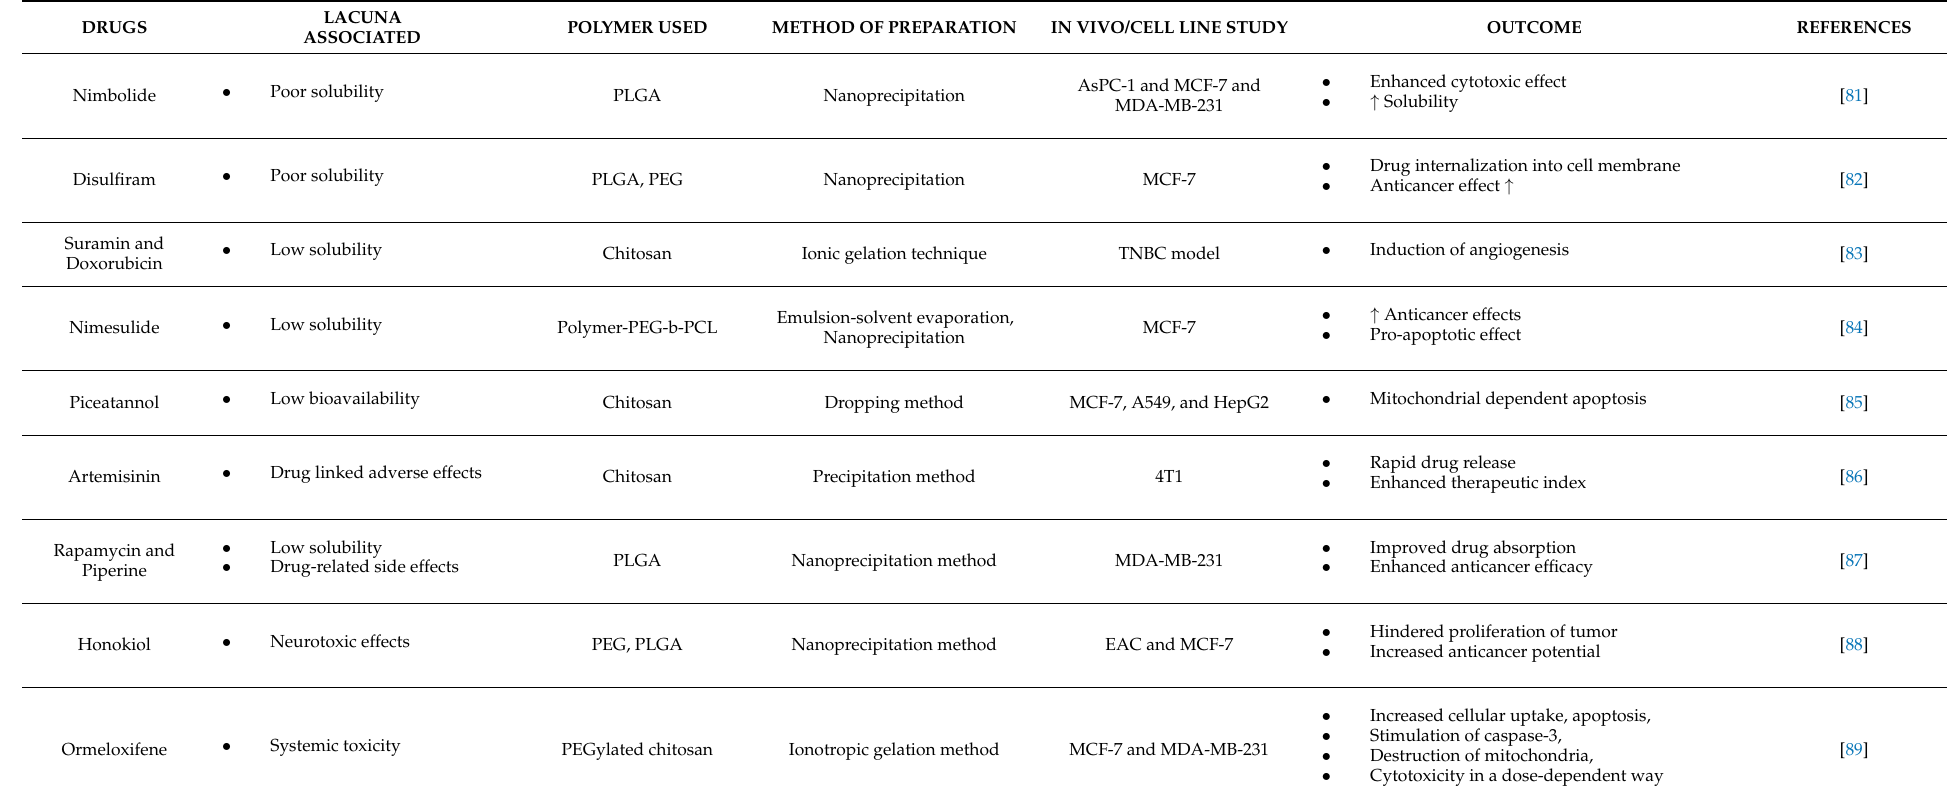
Table 6. Various chemotherapeutic drugs and phytoconstituents and their combination polymeric nanoparticles for breast cancer